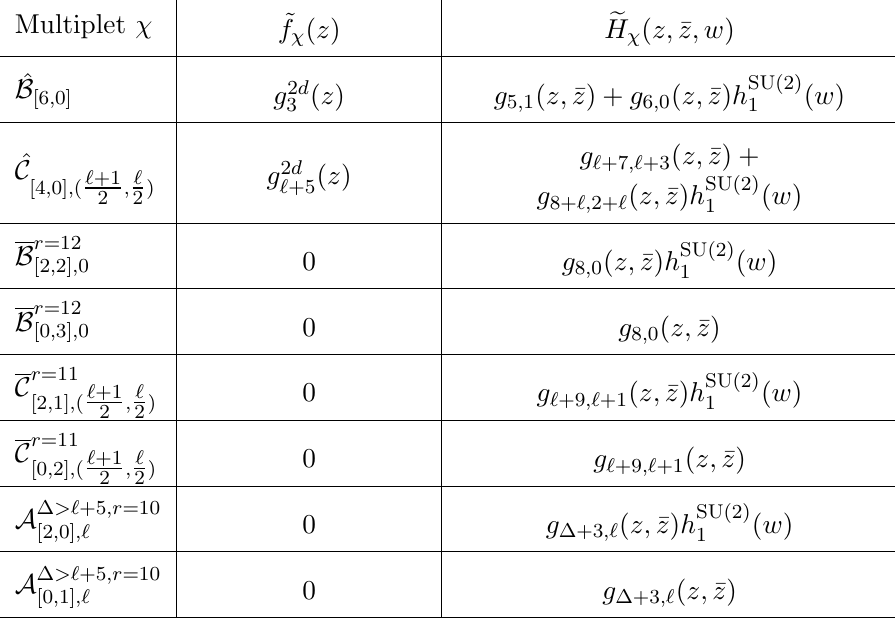
Table 7 . Contributions of the various N = 3 multiplets appearing in the chiral OPE (3.22), for R = 3, to the functions ~ f (cid:31) ( z ) and e H (cid:31) ( z; (cid:22) z; w ). Since we are interested in the correlation functions of identical operators, Bose symmetry under the exchange of the two identical operators forbids the multiplet B r =12 from appearing and restricts the ‘ to be even for A r =10 [0 ; 3] ; 0 ^ C , and odd for A r =10 and C r =11 [0 ; 1] ;‘ [2 ; 1] ; ( ‘ +1 2 ; ‘ 2) [4 ; 0] ; ( ‘ +1 2 ; ‘ 2)